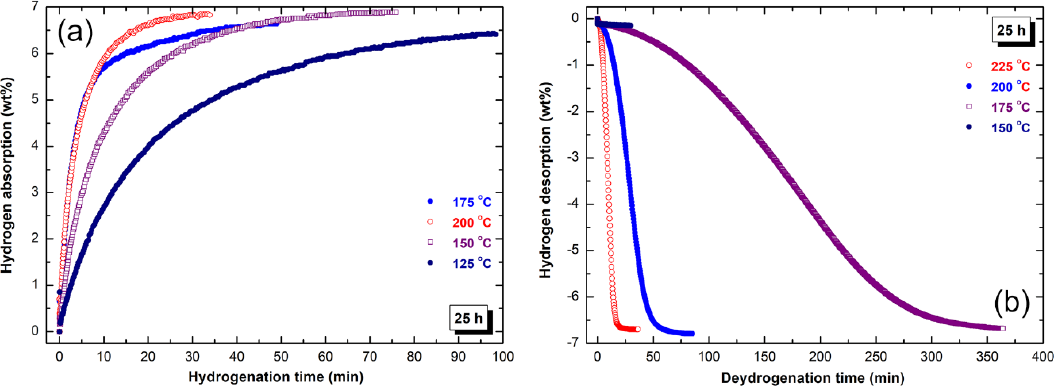
Figure 10. Kinetics of ( a ) hydrogenation and ( b ) dehydrogenation measured at different temperatures under hydrogen pressure of 10 bar and 200 mbar, respectively of rod-milled MgH 2 /7 wt% a-LaNi 3 for 25 h.